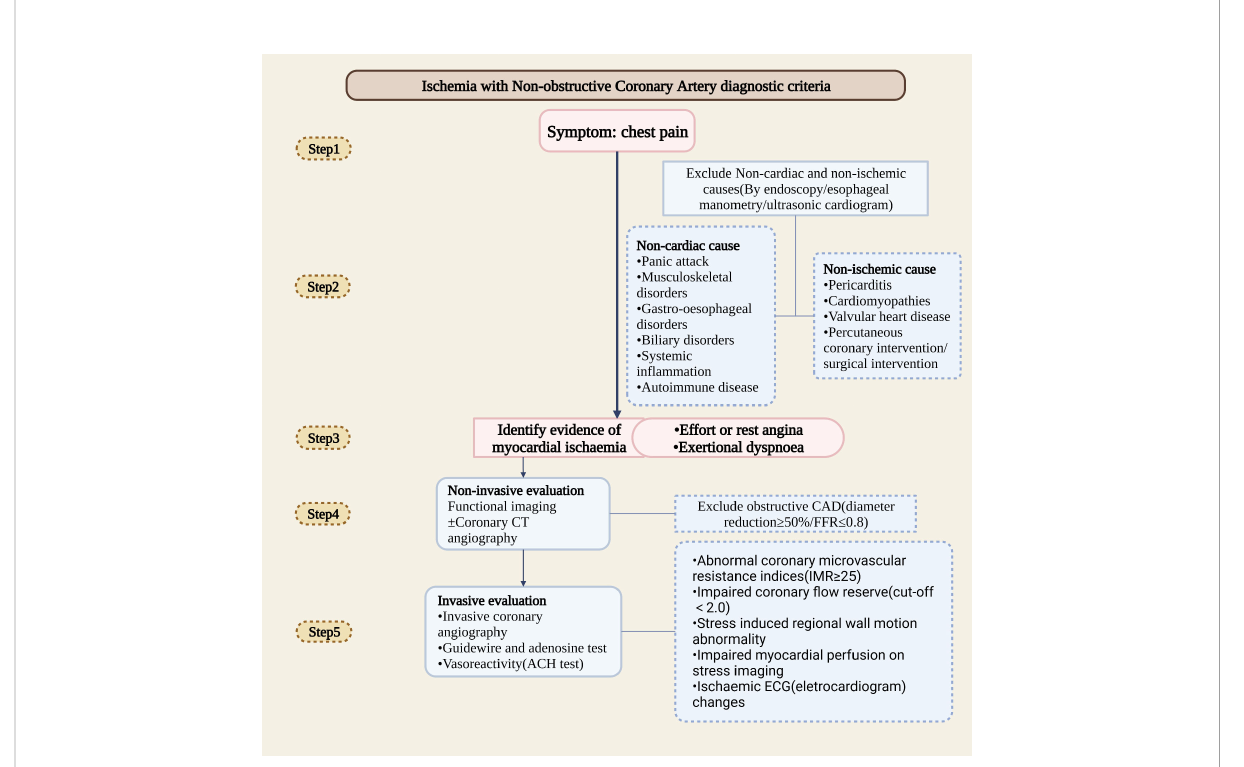
FIGURE 1 The clinical diagnostic assessment of INOCA. (Created with